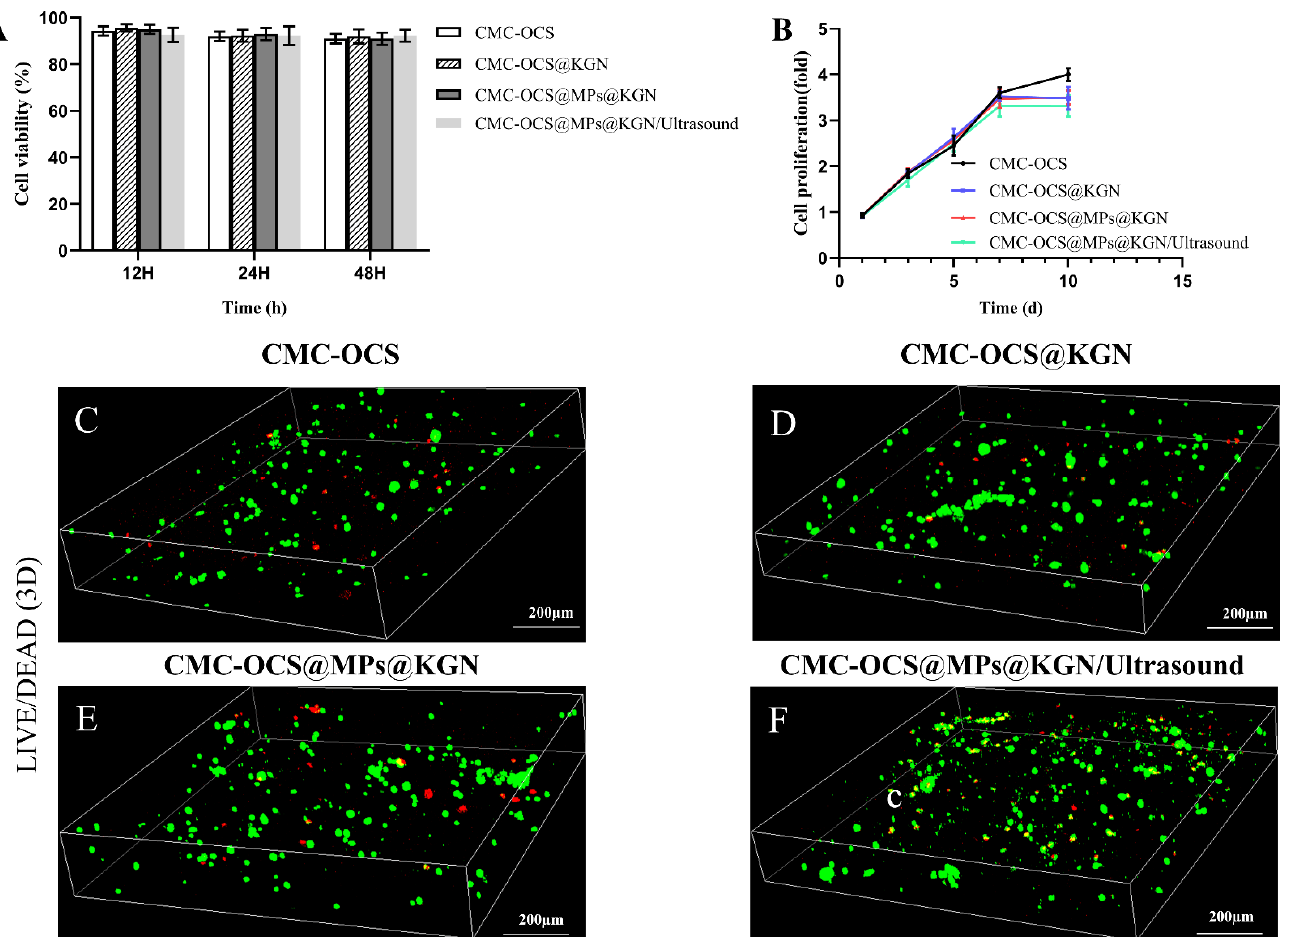
Figure 5. ( A ) Cytotoxicity assay using a CCK-8 kit. ( B ) Cell proliferation in four groups as detected with a CCK-8 assay. Data were normalized against the OD value on day 1 of each cell line. ( C – F ) Live/dead staining of rBMMSCs performed after 7 days of incubation with the four groups.